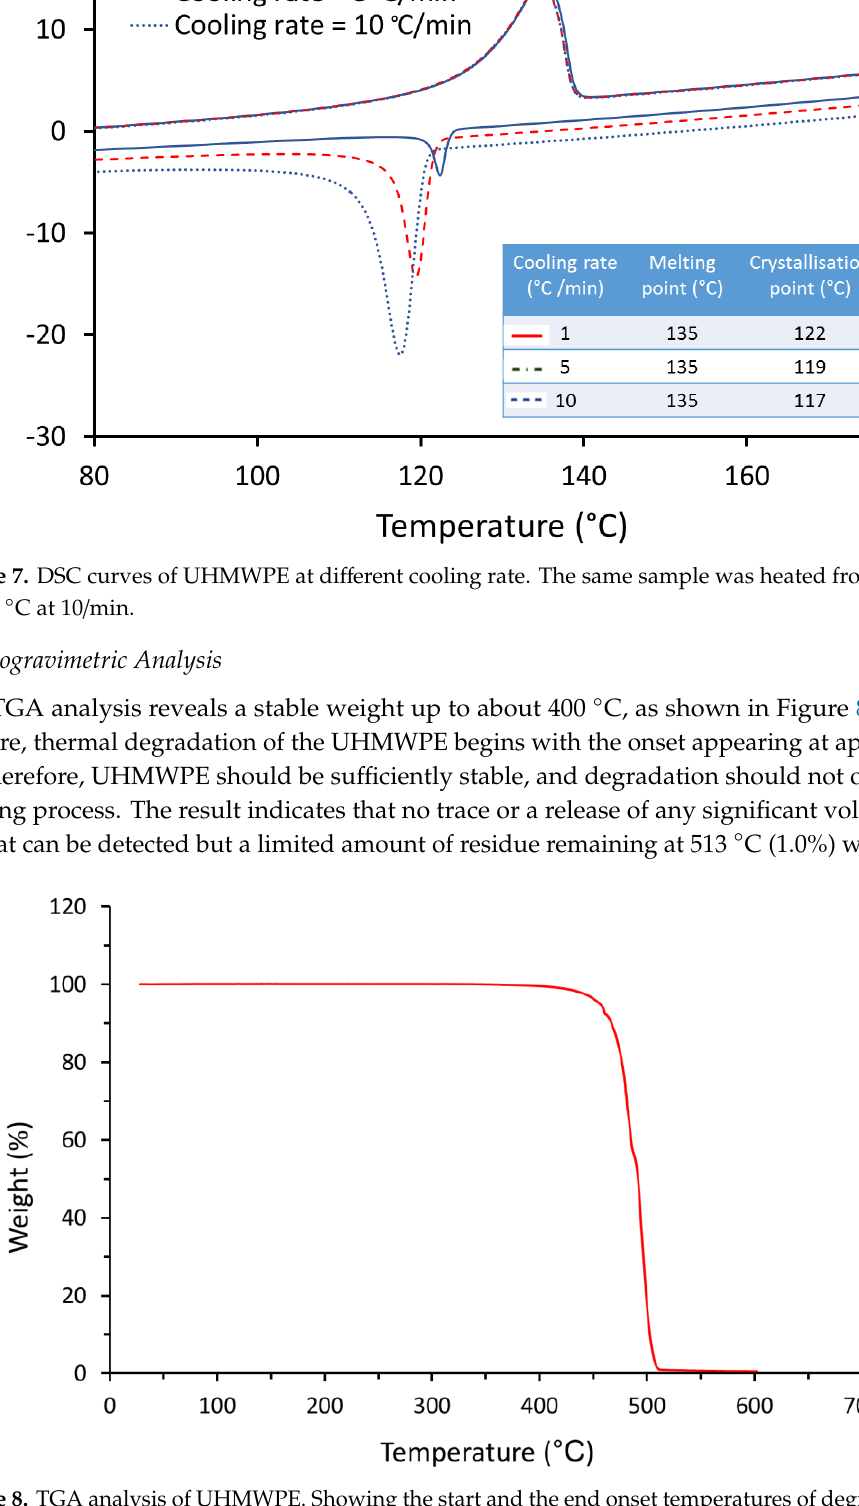
Figure 8. TGA analysis of UHMWPE. Showing the start and the end onset temperatures of degradation at 478 °C and 513 °C, respectively.